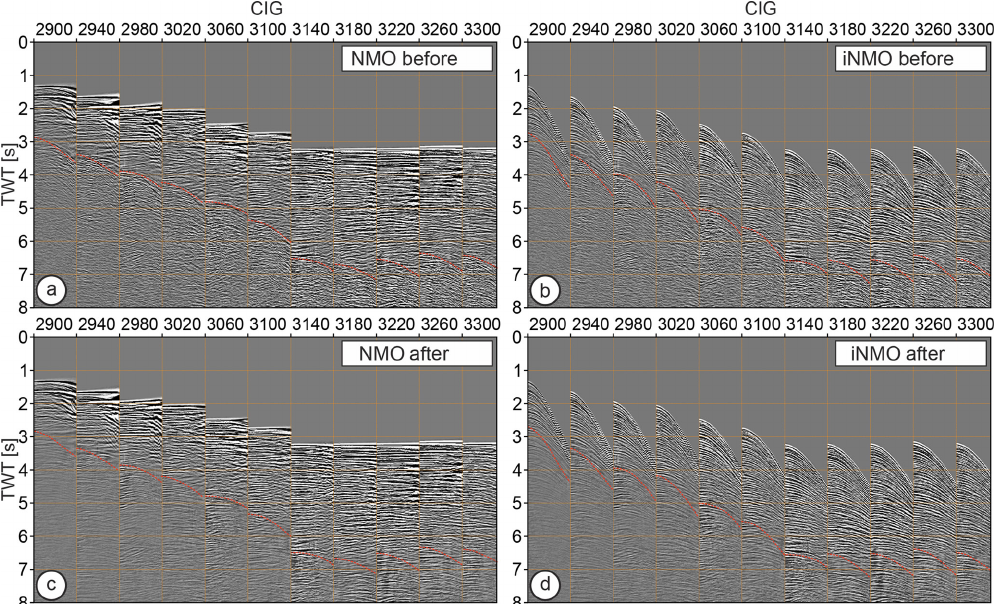
Figure 4. CIGs converted to time domain (a–b) before and (c–d) after radon multiple attenuation. Gathers in (a) – (c) are NMO-corrected, while gathers in (b) – (d) have inverse NMO applied. Red dashed curves delineate the estimated position of the